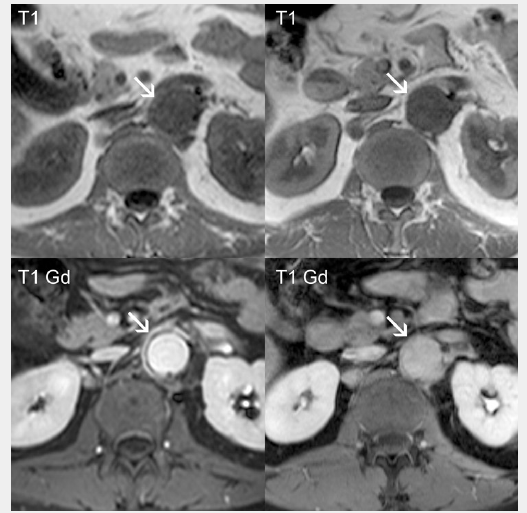
Abdominal magnetic resonance angiography of GCA patient 3 using a 3 Tesla scanner (first exam in the left column, right column after therapy). The inflammatory tissue is depicted as an irregular band with slightly higher signal intensity on non-enhanced T1 weighted images (arrows). After intravenous injection of paramagnetic contrast, this band enhanced conspicuously. After therapy with tocilizumab for three months, the extent of the band decreased and signal intensity after paramagnetic contrast was also considerably